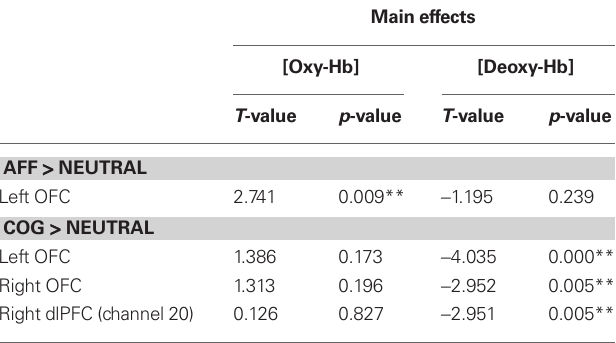
Table 3 | Significant findings for verbal listening